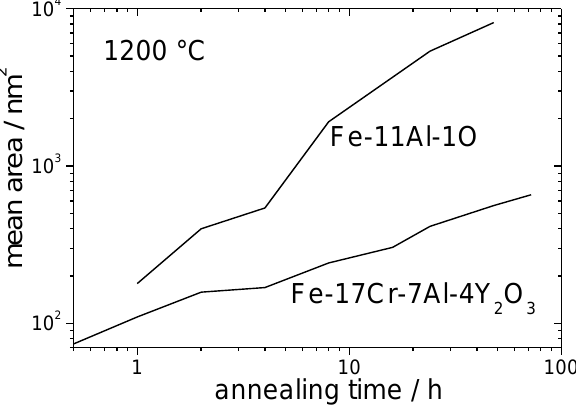
Figure 9. Evolution of mean oxide cross-section areas in both systems.